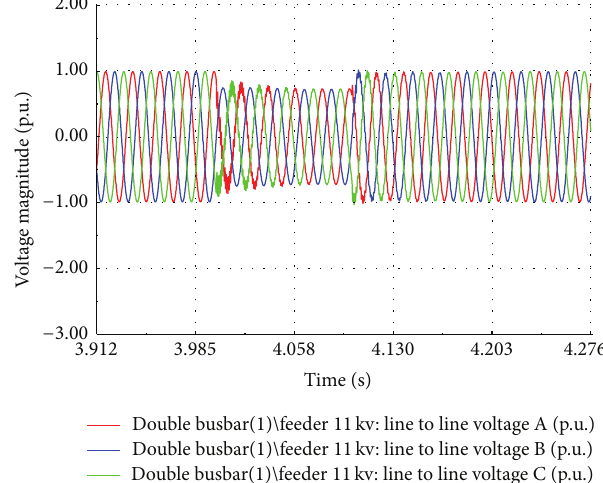
Figure 18: Simulated voltage sag in p.u.